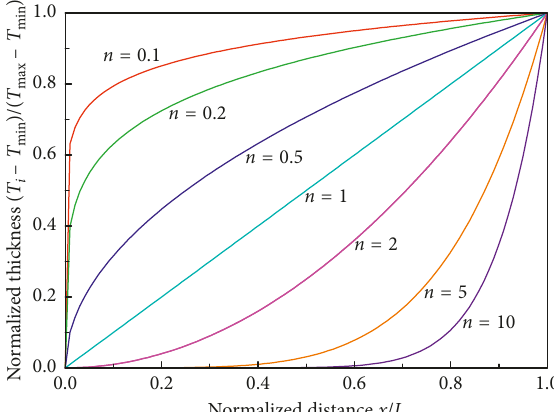
Figure 3: Variation of thickness vs. normalized